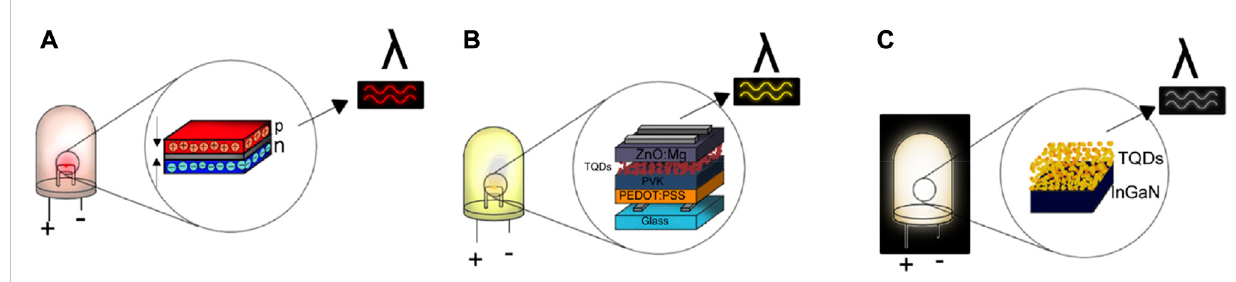
FIGURE 3 Design of LEDs based on TQDs: (A) classical con fi guration, (B) example of modern con fi guration, (C)